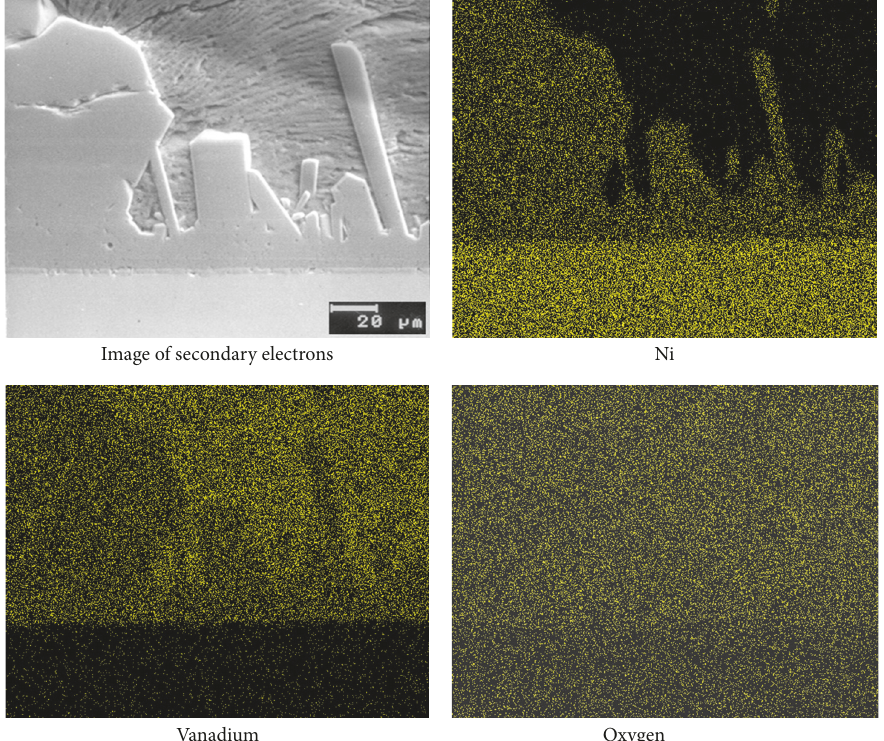
Figure 8: Cross sectional aspect of Ni and element mapping, after LPR measurements in NV3 at 800 ∘ C for 24 hours.